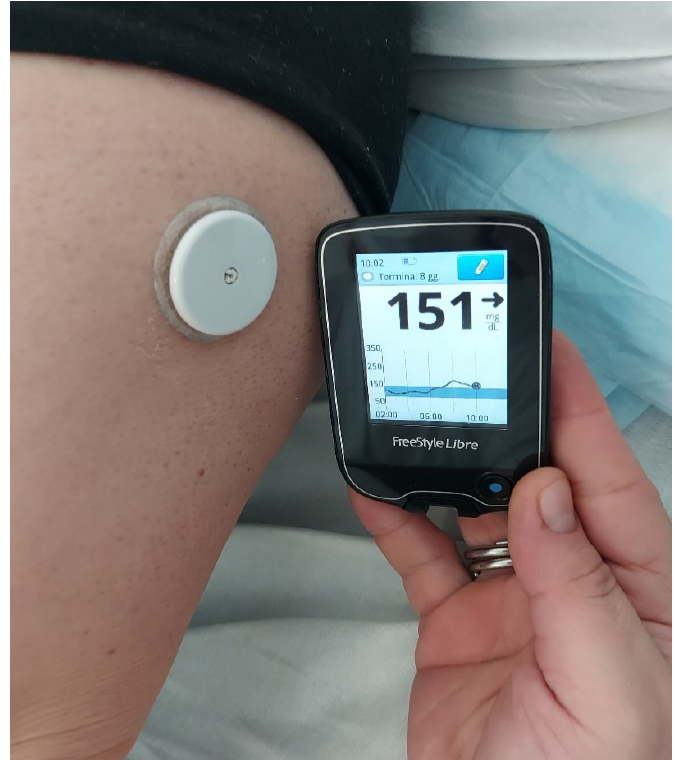
Figure 2. The sensor is applied to the arm of a patient with a subcutaneous needle measuring interstitial glucose levels. Measurements are viewed on a receiver unit (either a smartphone or dedicated receiver unit). This model is a FreeStyle Libre.